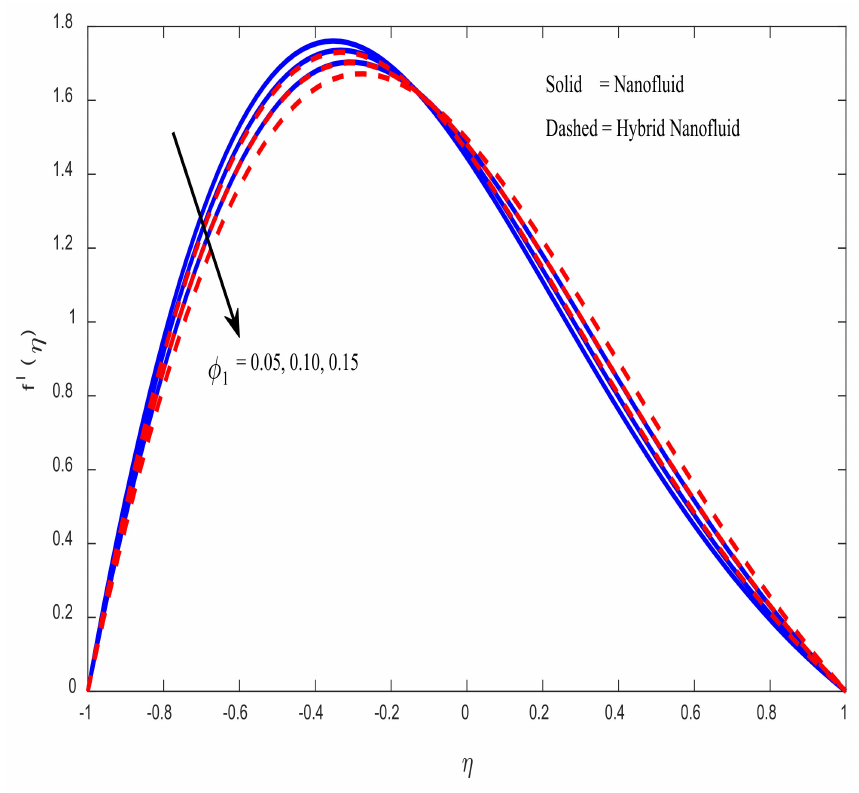
Figure 6. Influence of φ 1 on the velocity